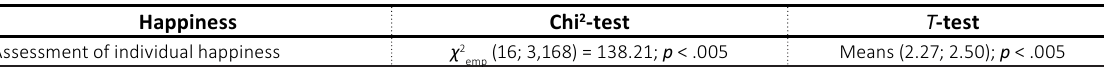
Figure 3. Visualization of correlation of assessing sporting performance and assessing individual happiness Table 9. Result of Chi 2 -tests and the T -tests concerning the assessment of individual happiness Happiness Chi 2 -test T -test